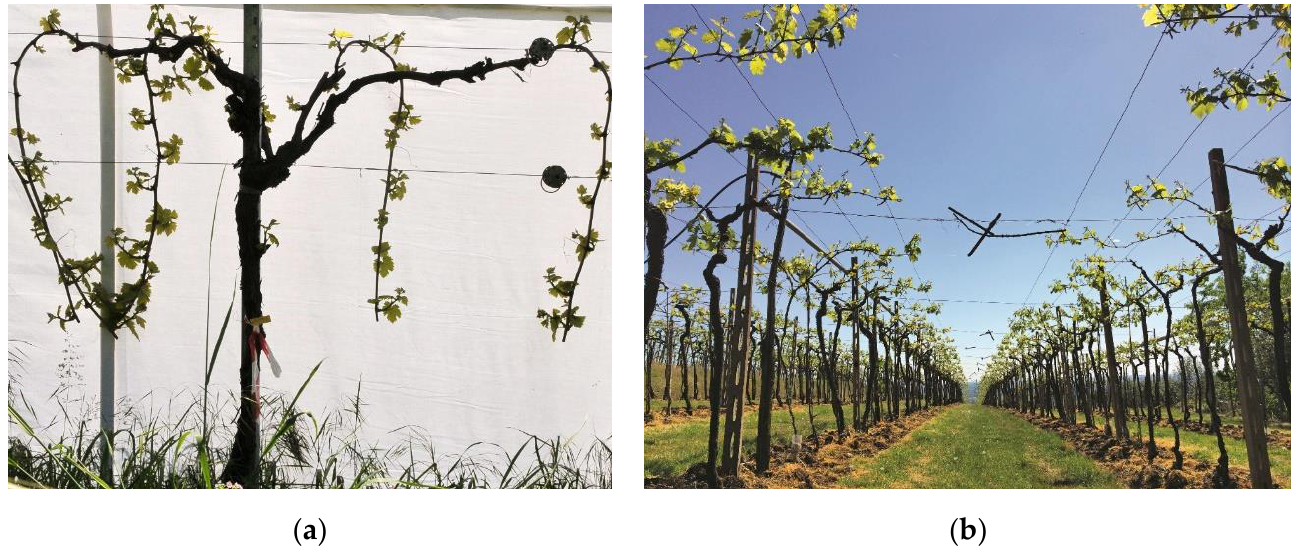
Figure 1. Training systems in experimental vineyards: ( a ) Vidor “Doppio capovolto” training systems, ( b ) Soave “Pergola veronese” training system.